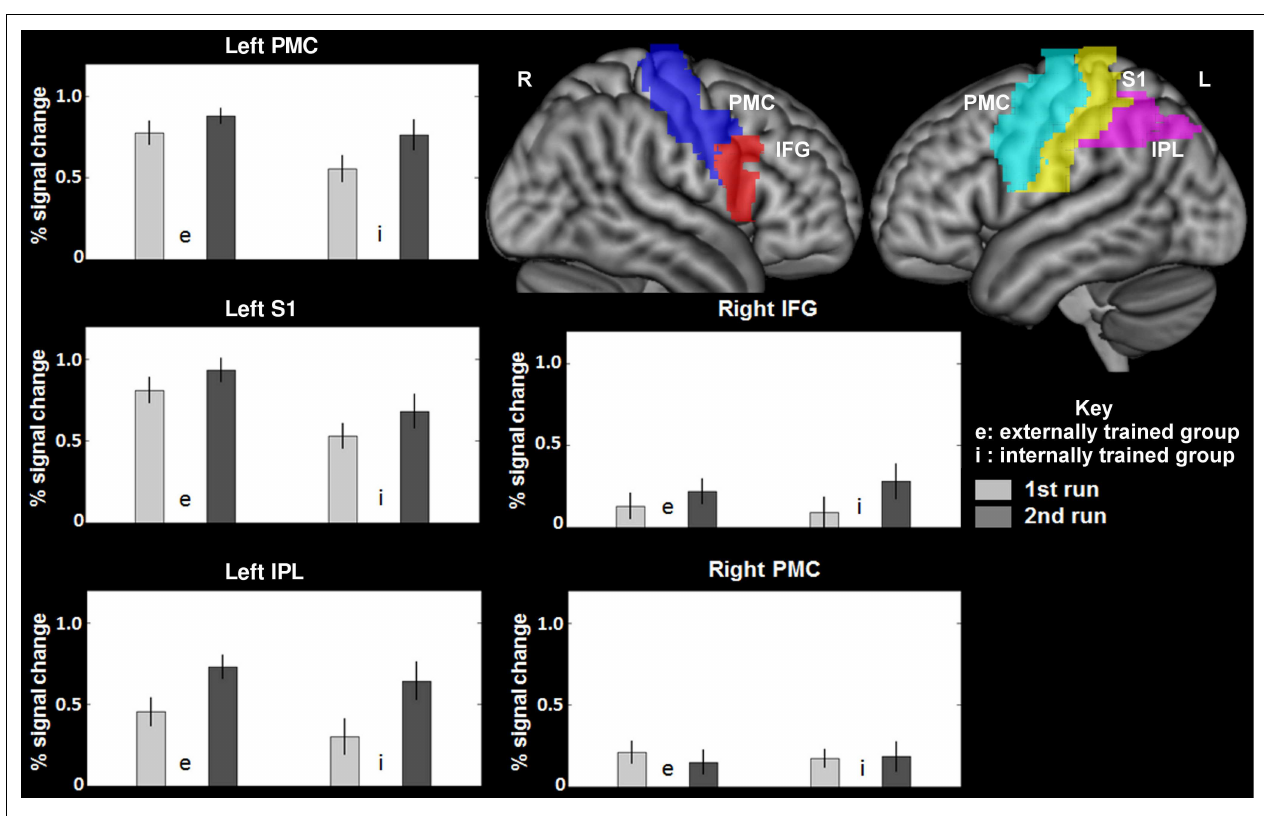
and the right inferior frontal gyrus (opercular part). IPL, Inferior parietal lobule (the dorsal part, excluding the supramarginal and angular gyri); PMC, premotor cortex (in precentral gyrus); S1, primary somatosensory cortex (postcentral gyrus); IFG, Inferior frontal gyrus, opercular